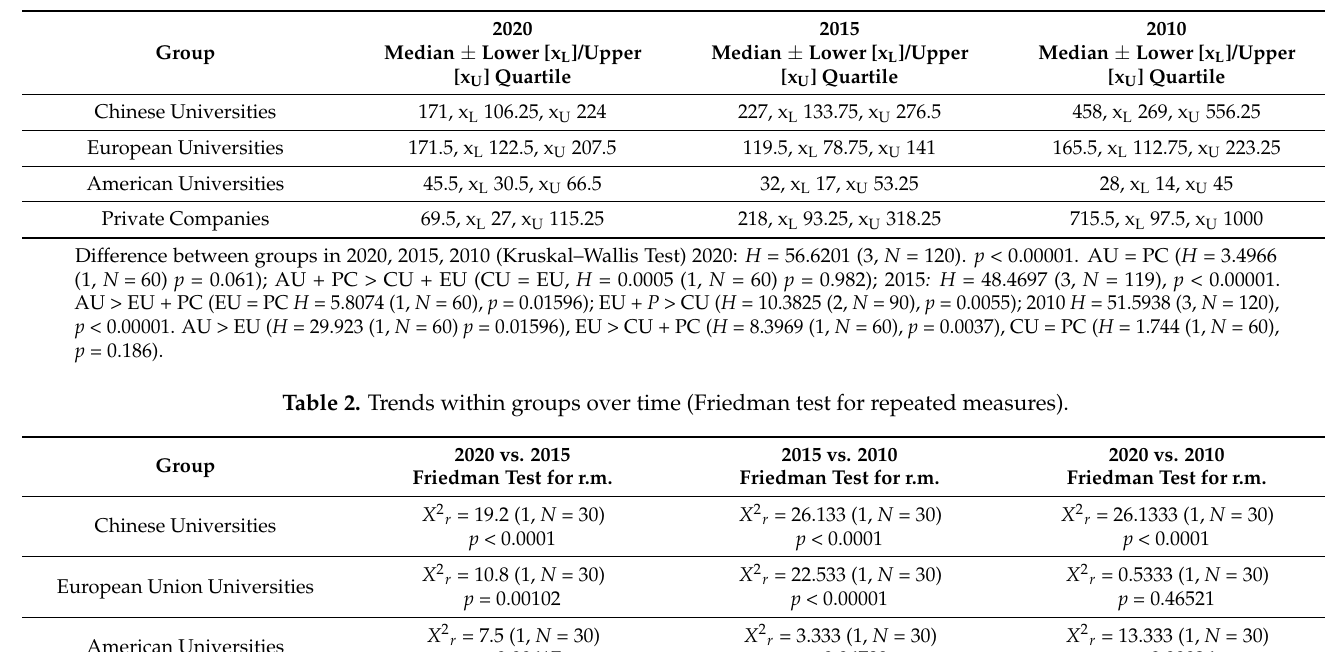
Table 1. Trends 2010–2020 on SCImago institutions rankings (SIR) of the best 30 universities of China, the European Union, the US, and of the best 30 private companies.